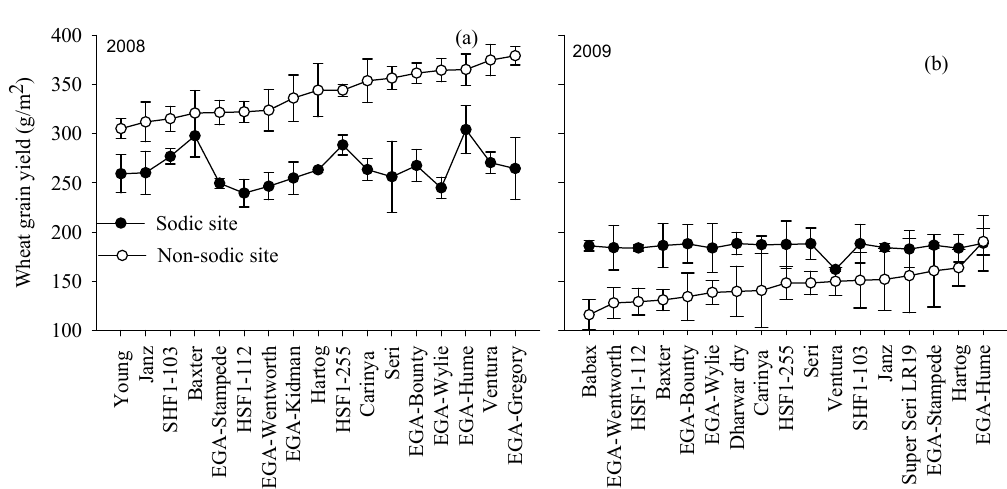
Figure 3. Grain yields ranking of wheat genotypes grown on a sodic site and a non-sodic site Figure 2. Grain yields ranking of wheat genotypes grown on a sodic site and a non ‐ sodic site in ( a ) in ( a ) 2008 and ( b ) 2009 near Goondiwindi in southern Queensland. 2008 and ( b ) 2009 near Goondiwindi in southern Queensland.